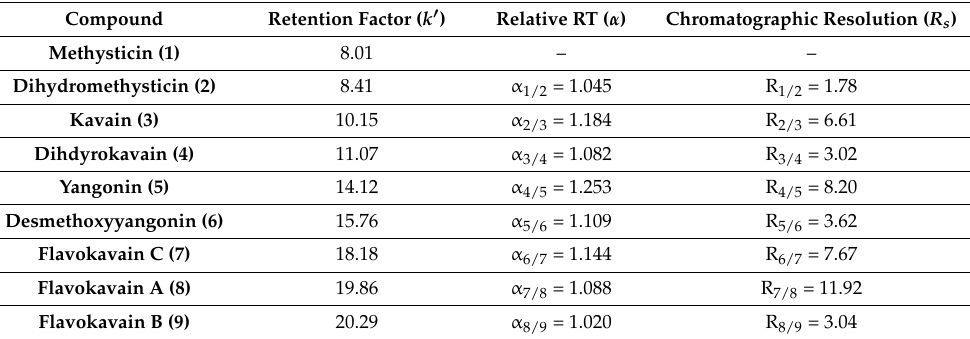
Table 2. Parameters of kavalactones and flavokavains.